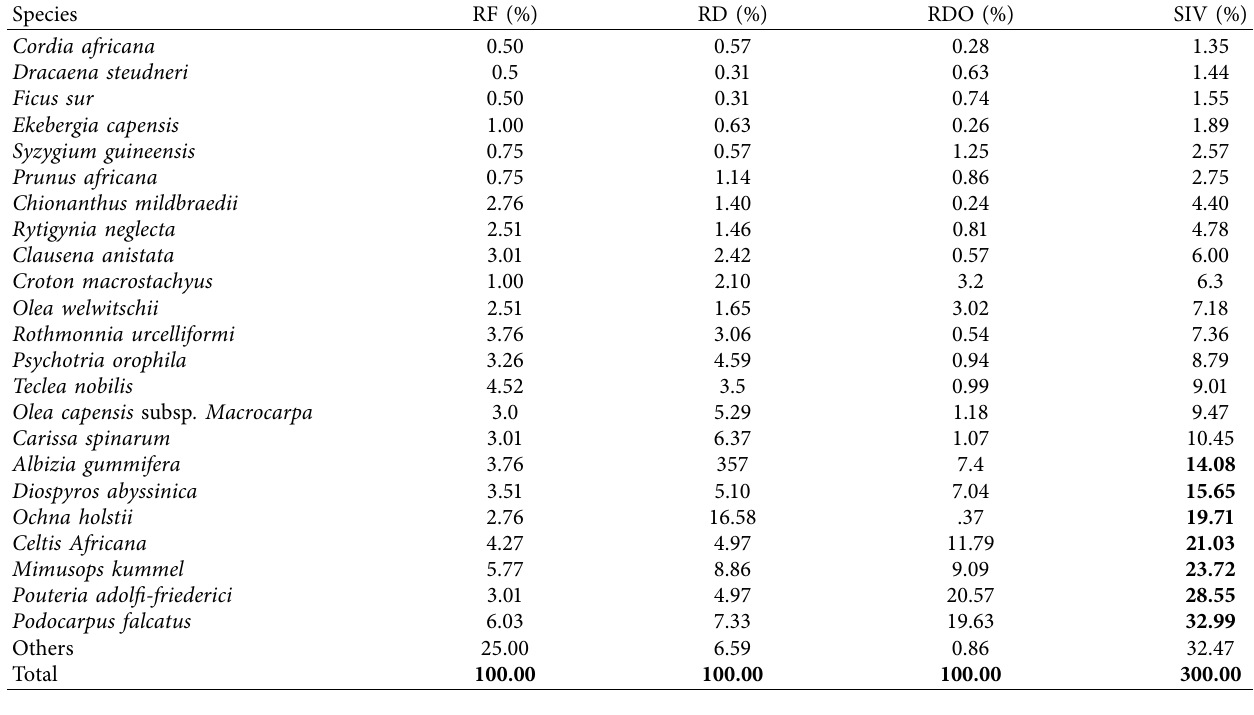
Table 6: The IVI of woody species in the sampled area with corresponding values for each species.